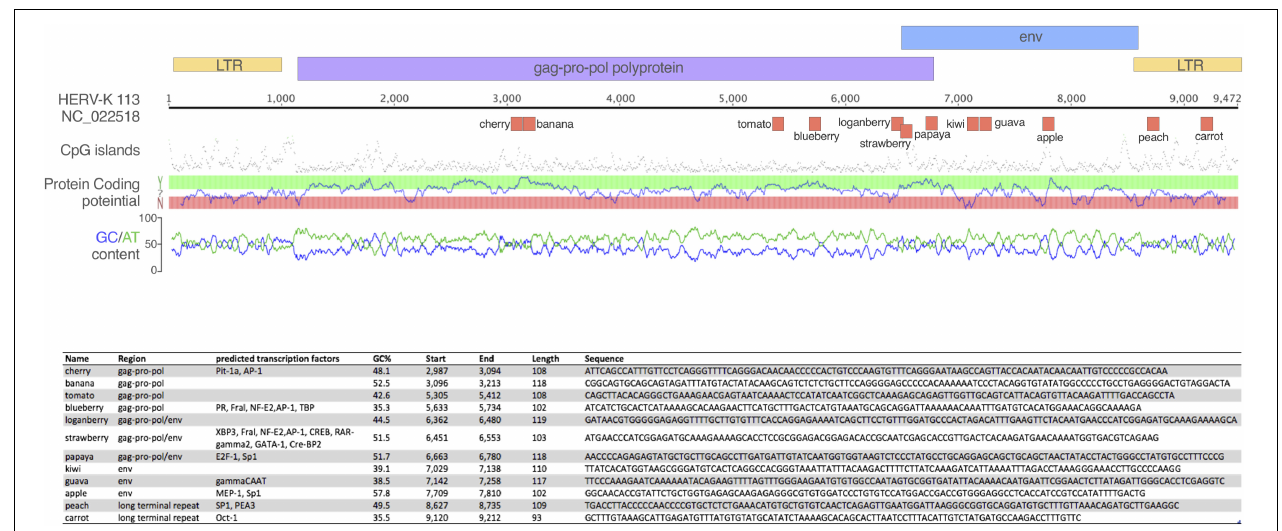
FIGURE 1 | Oligonucleotides tested in the study. The schematic depicts the oligos tested in the study mapped onto the HERV-K113 genome. Above the ruler, the colored boxes represent the retroviral ORFs and LTR regions; below are the oligos, which are named for ease of reference. Corresponding statistics for each oligo are presented in the table, including the sequence of each oligo.